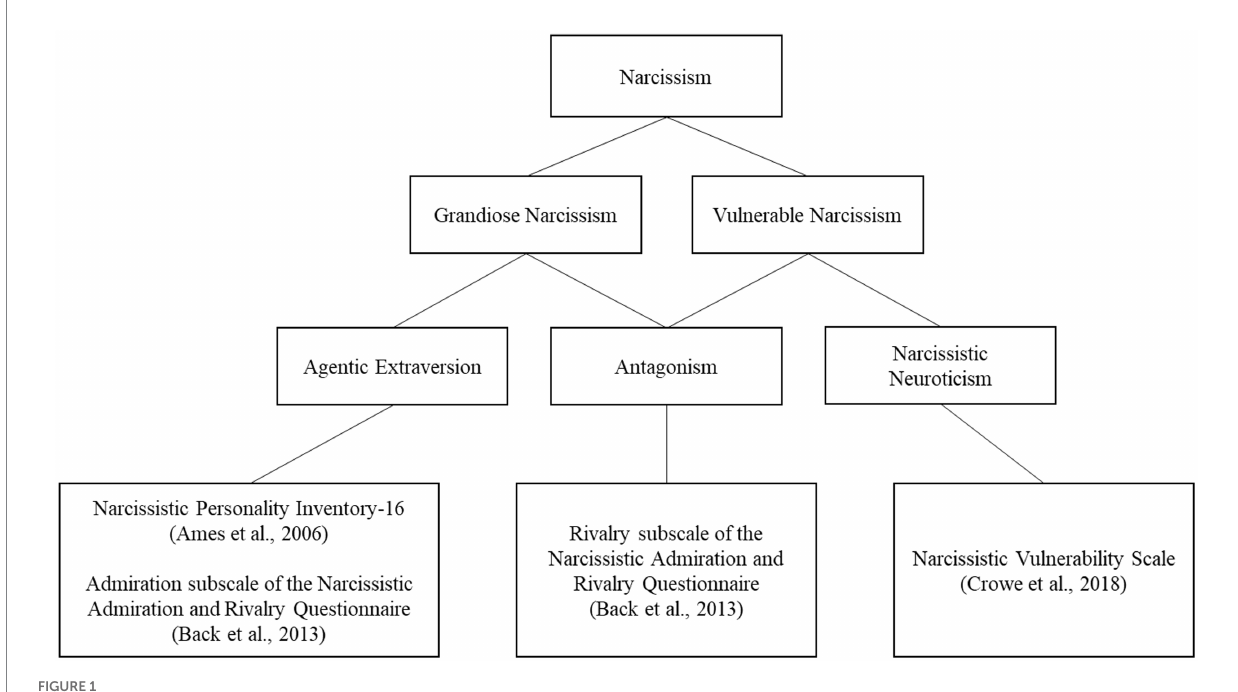
FIGURE 1 A representation of the Trifurcated Model of Narcissism and the assessments used to measure each of the three factors of narcissism in the present